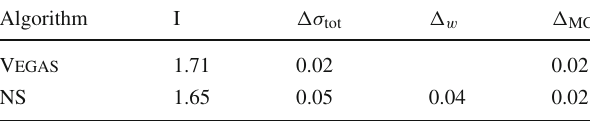
Table 2 Comparison of integrals calculated in the toy example with V EGAS and NS, along with the respective